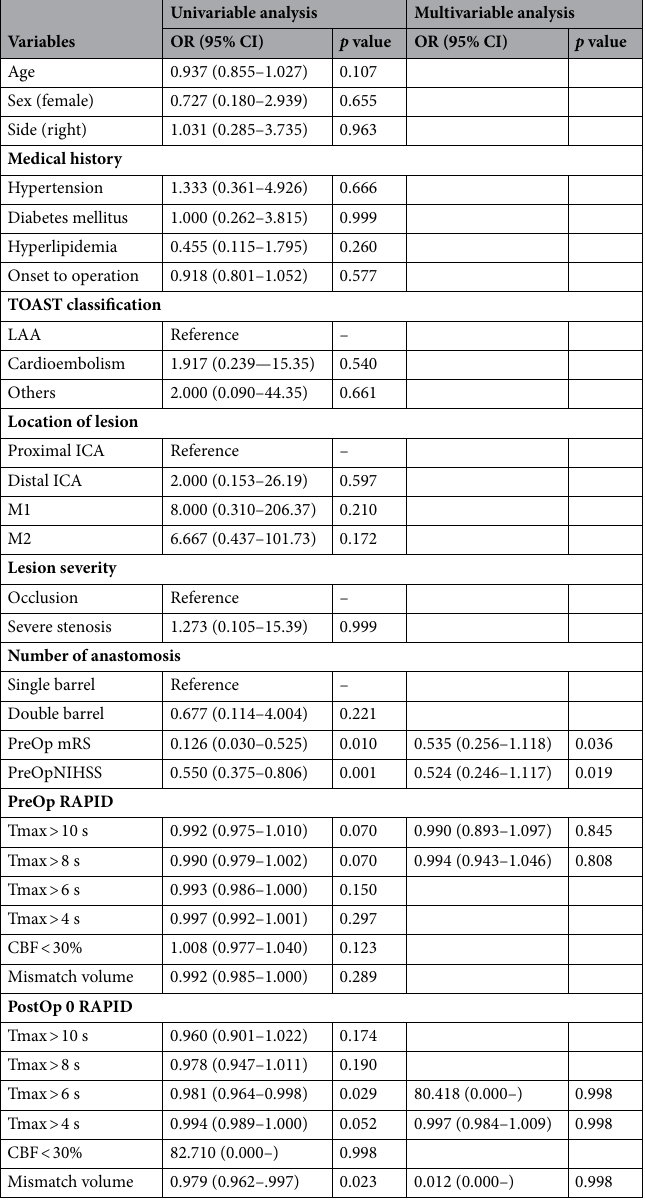
Table 3. Univariable and multivariable analysis of factors affecting good outcome. CBF, cerebral blood flow; CI, confidence interval; mRS, ICA, internal carotid artery; LAA, large-artery atherosclerosis; modified Rankin Scale; NIHSS, National Institute of Health Stroke Scale; OR, odds ratio; preOp, preoperative; postOp 0, immediate postoperative; s, seconds; Tmax, time-to-maximum; TOAST, Trial of Org 10172 in Acute Stroke